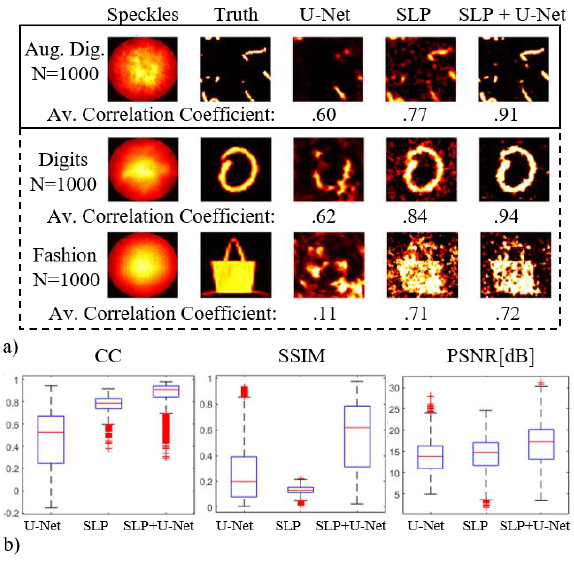
Fig. 2. Comparison between U-Net, SLP and SLP+U-Net after training with Augmented Digits data. a) Reconstruction examples. The CC data set average over N images is displayed below the reconstructions. b) CC, SSIM & PSNR boxplots of all data sets combined .